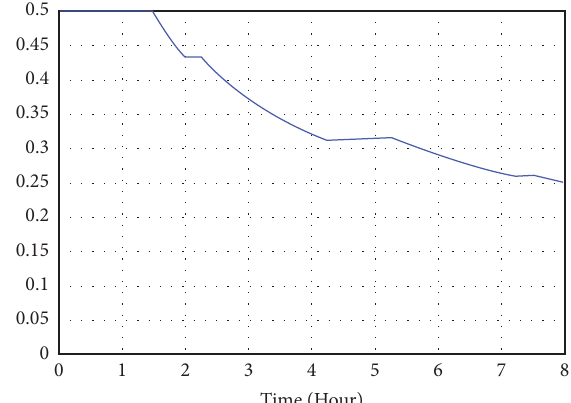
Figure 8: Variation of operational complexity PSF with working time.